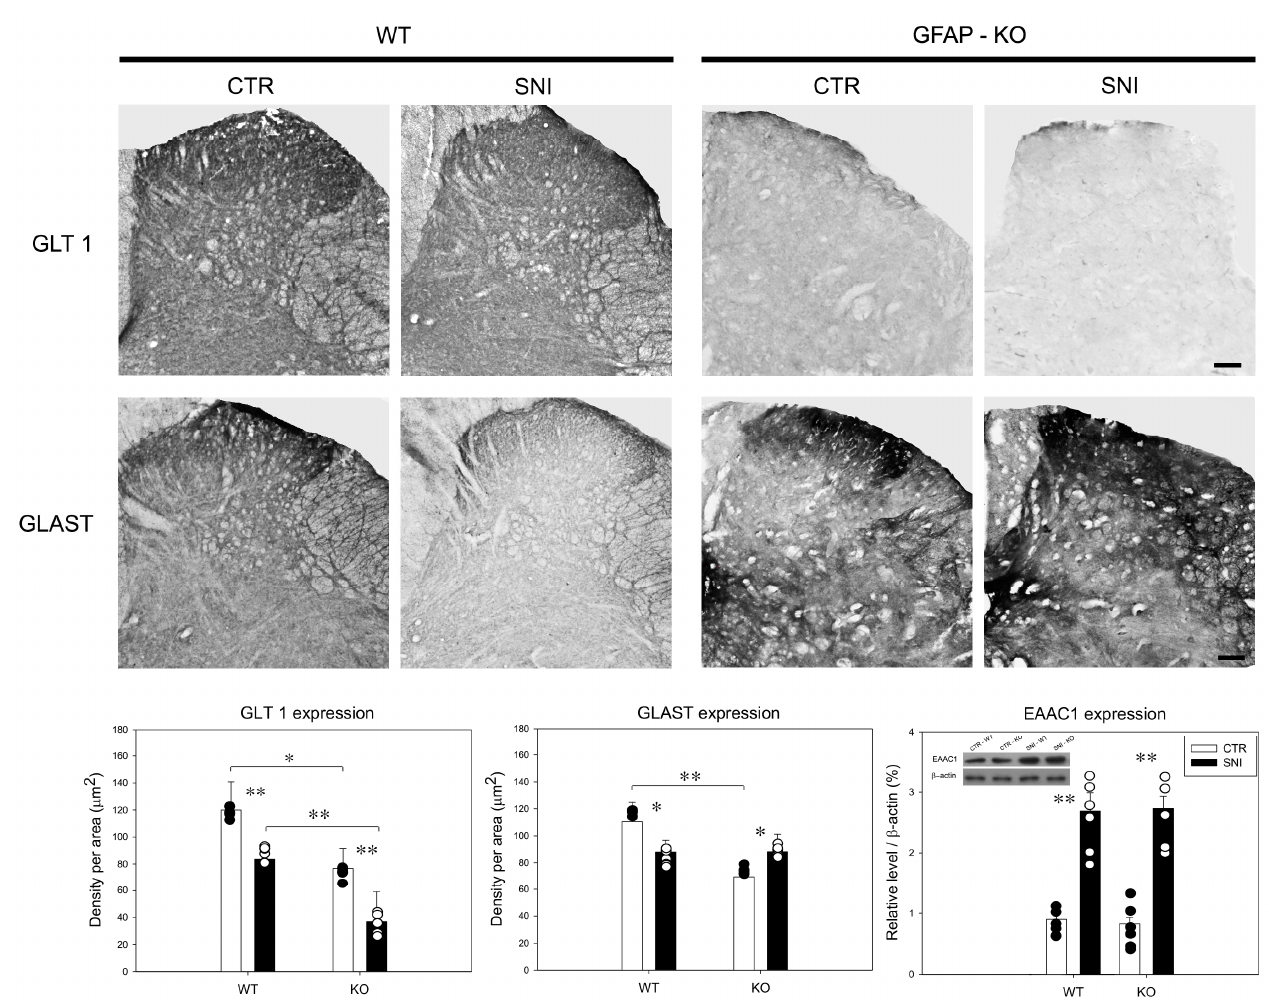
Figure 4. Expression of glial (GLT 1, GLAST) and neuronal (EAAC1) glutamate transporters in the dorsal horn of the spinal cord. Data are expressed as the mean ± SEM (** p ≤ 0.001; * p ≤ 0.01). In GFAP-KO animals, GLT1 expression was reduced after nerve injury (36.9 ± 22.1) compared to CTR-KO animals (76.6 ± 14.9) ( p ≤ 0.001). Interestingly, GLT 1 expression